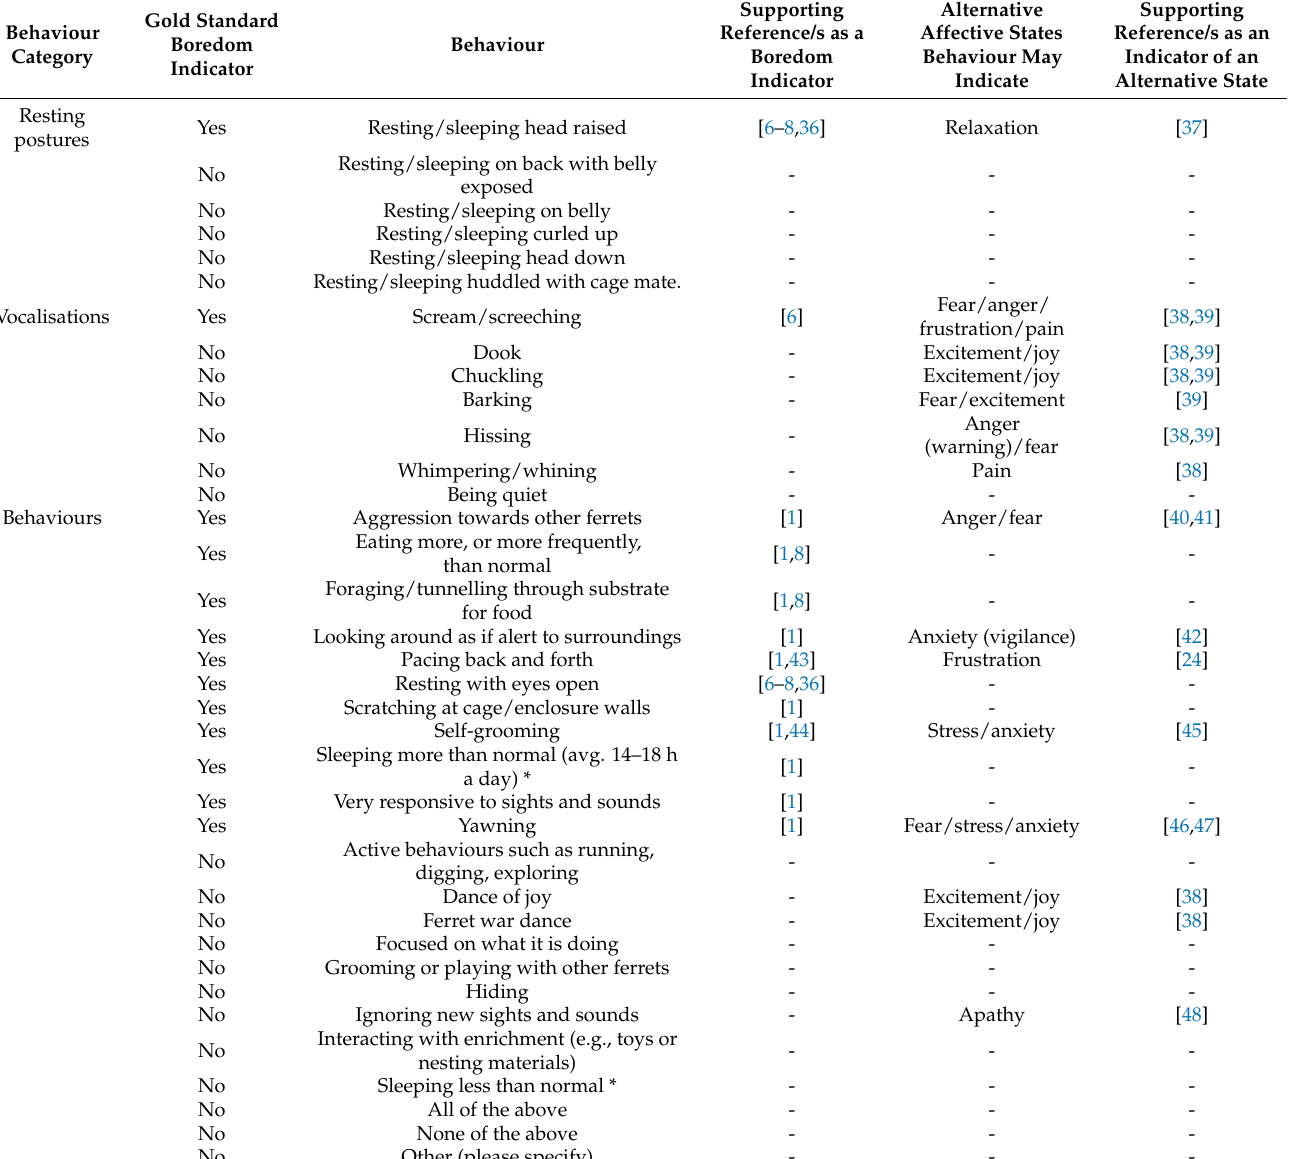
Table 1. The list of behaviours respondents could select from for the questions ‘Which behaviours might you expect to see from a [happy/relaxed/fearful or distressed/bored] ferret?’. The questions were presented in a tick-all-that-apply format. Behaviours identified from the literature as being potential boredom-indicators (gold standard boredom indicators) are indicated (yes/no); this informa- tion was not shown to respondents. The order these behaviours were presented in was randomised for each respondent. Where potential behavioural indicators of boredom may also indicate alternative affective states, these are listed. Additionally, for behaviours that are not considered indicators of boredom, but which may reflect other affective states, these states are